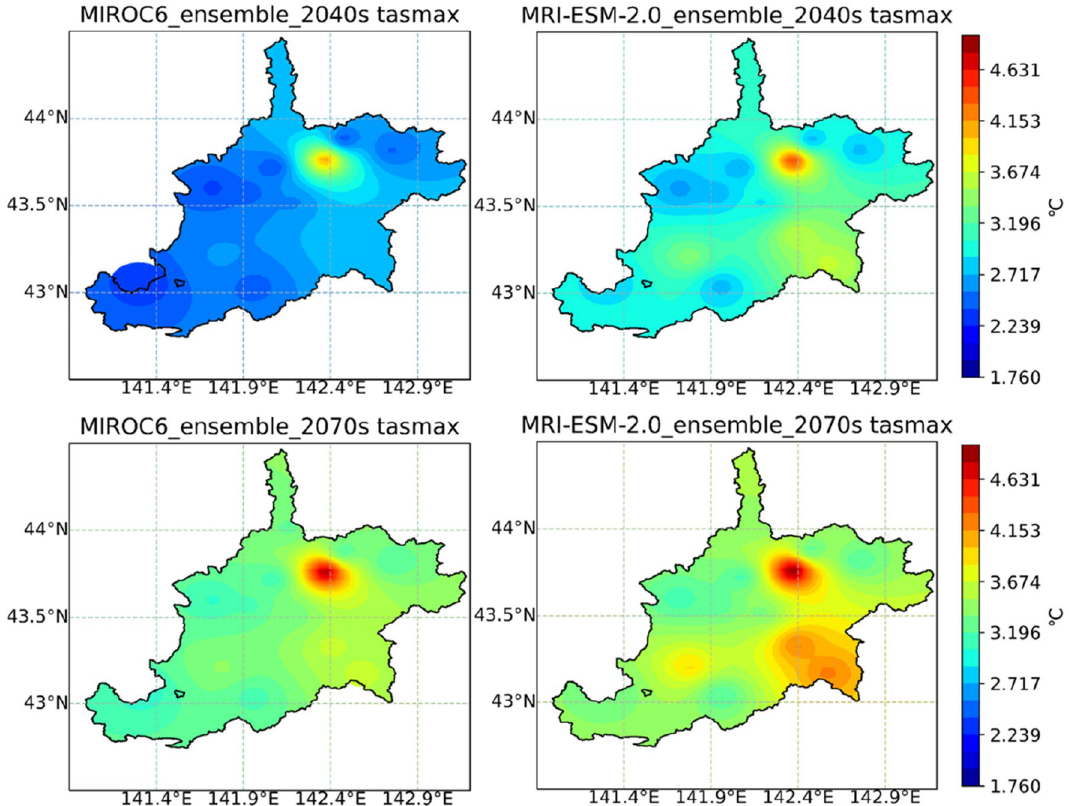
Figure 10. Changes in the maximum temperature (tasmax) of the Ishikari River basin in periods of the 2040s and 2070s under MIROC6 and